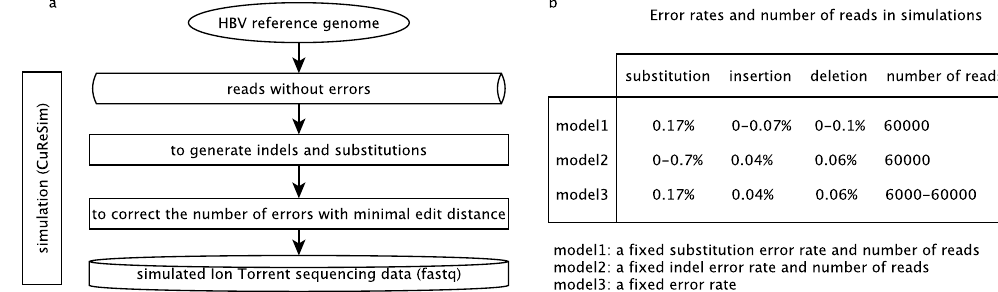
Figure 6. A framework for simulating PGM data. ( a ) Steps for simulating PGM data based on a reference genome using ‘CuReSim’ 40 . ( b ) A series of simulation scenarios with a fixed substitution error rate (model 1), a fixed indel error rate (model 2), and a fixed error rate (model